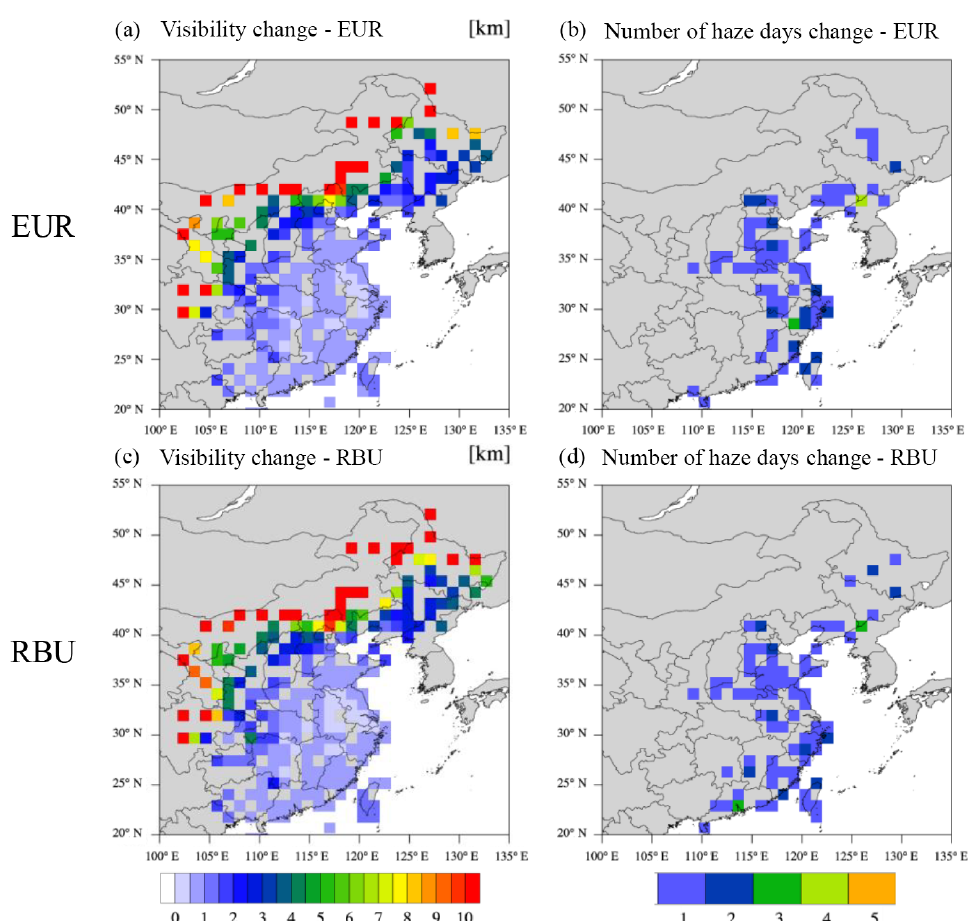
Figure 10. Reduction of visibility (a, c) and enhancement of number of haze days (b, d) under the EURALL (a, b) and RBUALL (c, d)